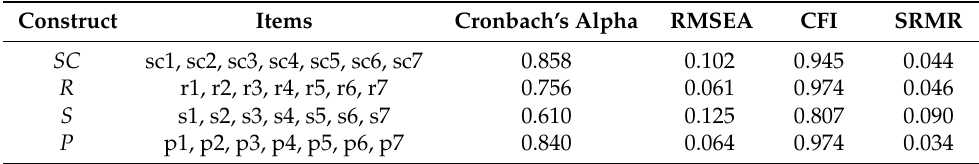
Table 3. Measurement constructs.